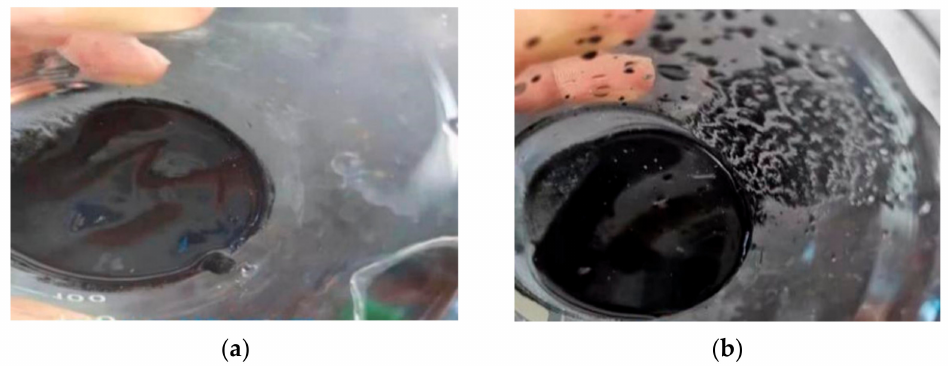
Figure 15. Appearance of sludge in the EGSB and IC reactors. ( a ) Sludge in the EGSB reactor. ( b ) Sludge in the IC reactor.